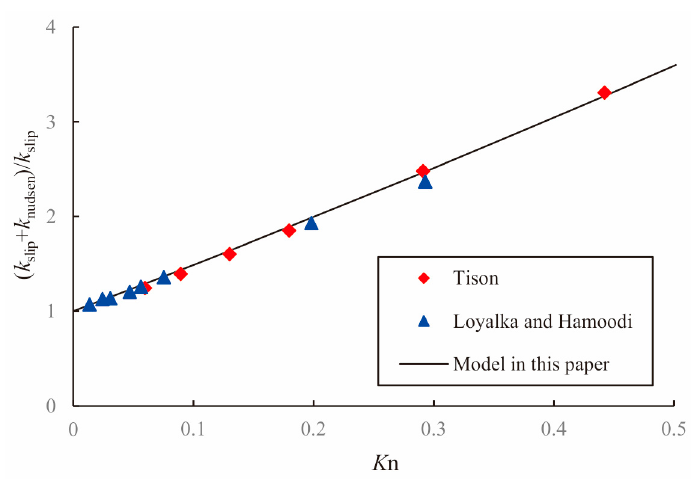
Figure 6. Bulk phase gas-permeability model validation compared with published data [70,71].